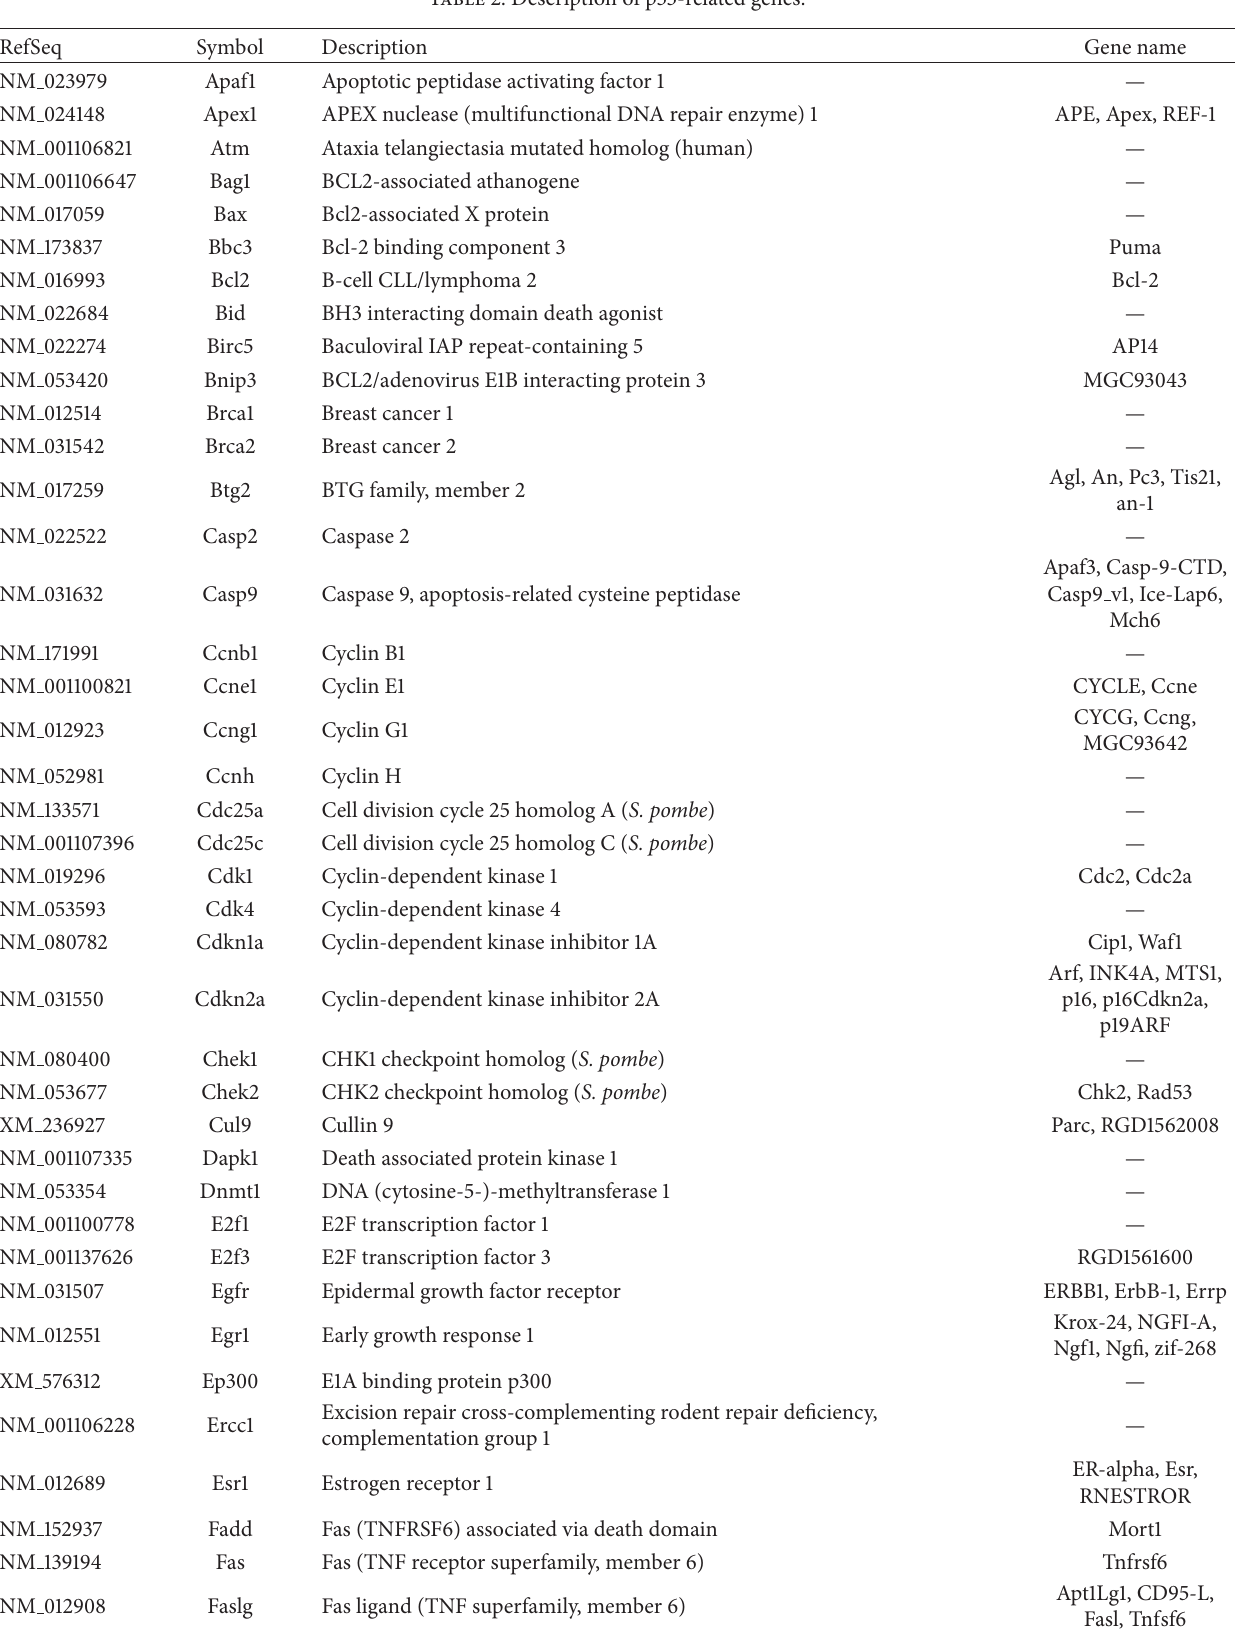
Table 2: Description of p53-related